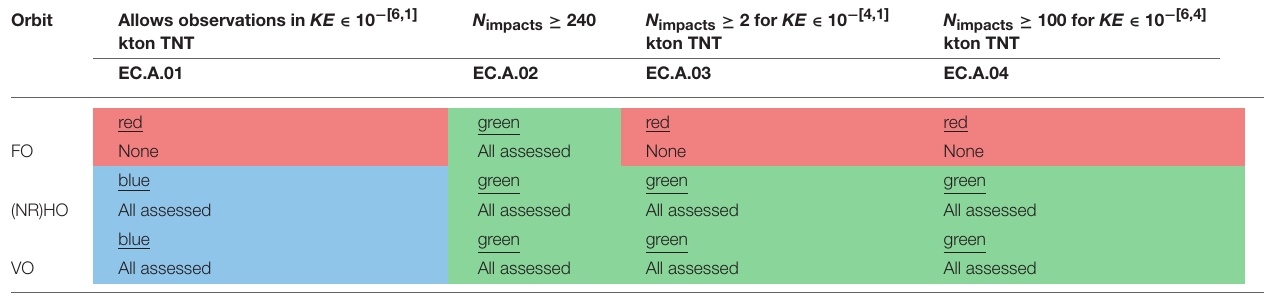
TABLE 7 | First orbit trade-off, given the results of both luminous efficiency method and blackbody method. Orbit Allows observations in KE ∈ 10 − [6,1]